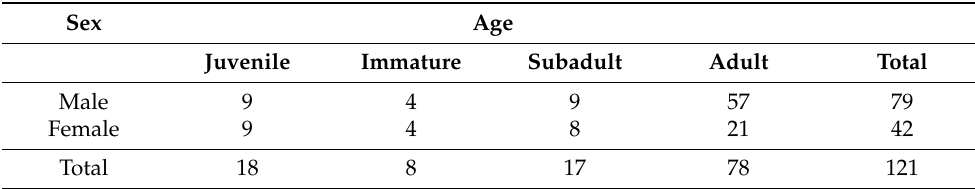
Table 1. Age distribution of male and female Common Eiders.